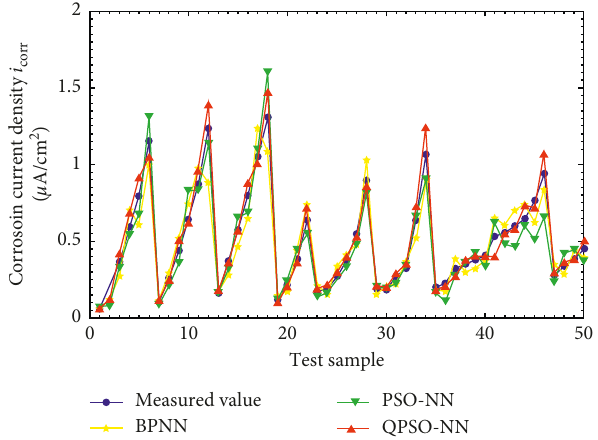
Figure 11: Prediction results of the QPSO-NN model, PSO-NN model, and BPNN